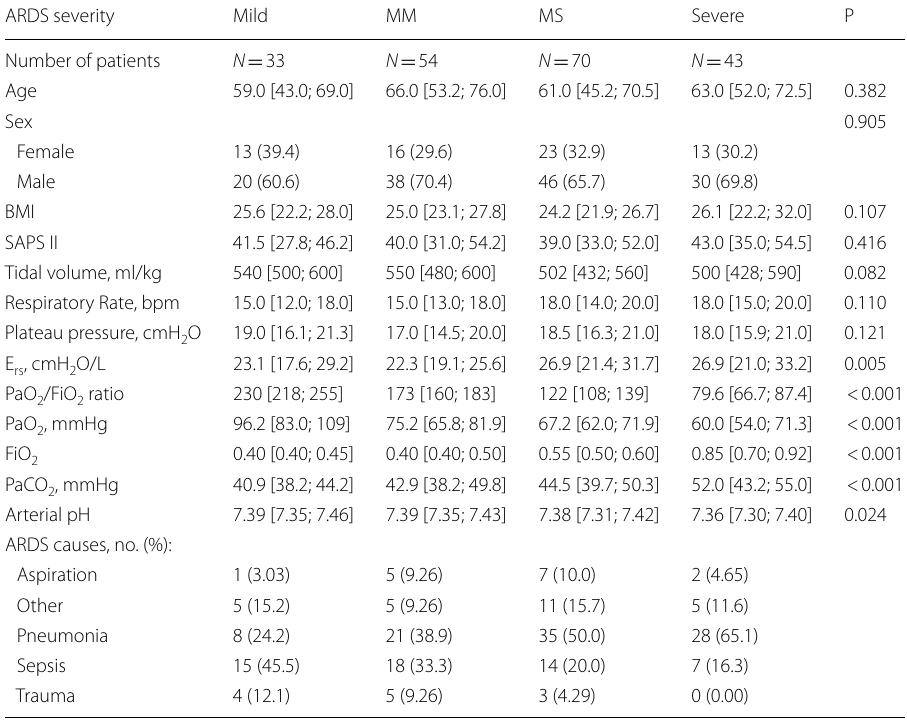
Table 1 Baseline characteristics among ARDS groups